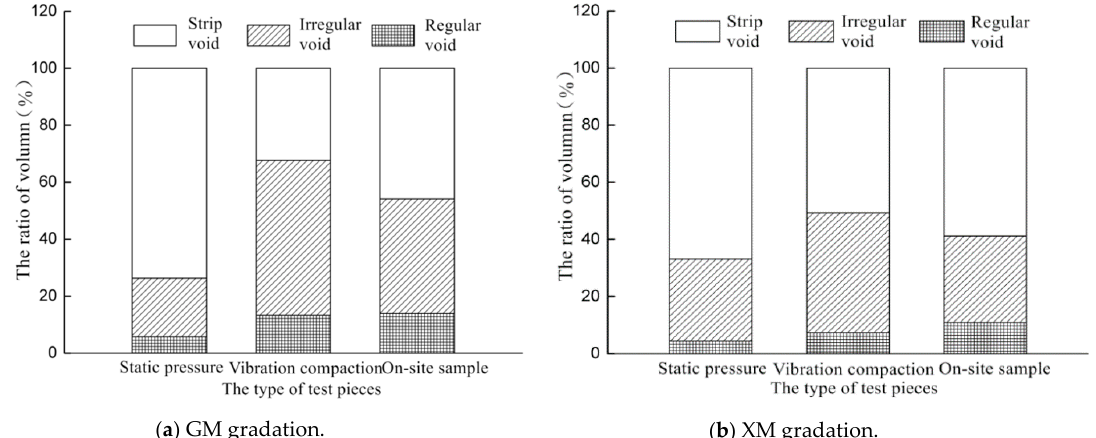
Figure 7. The void types of the XM and GM graded mixture.